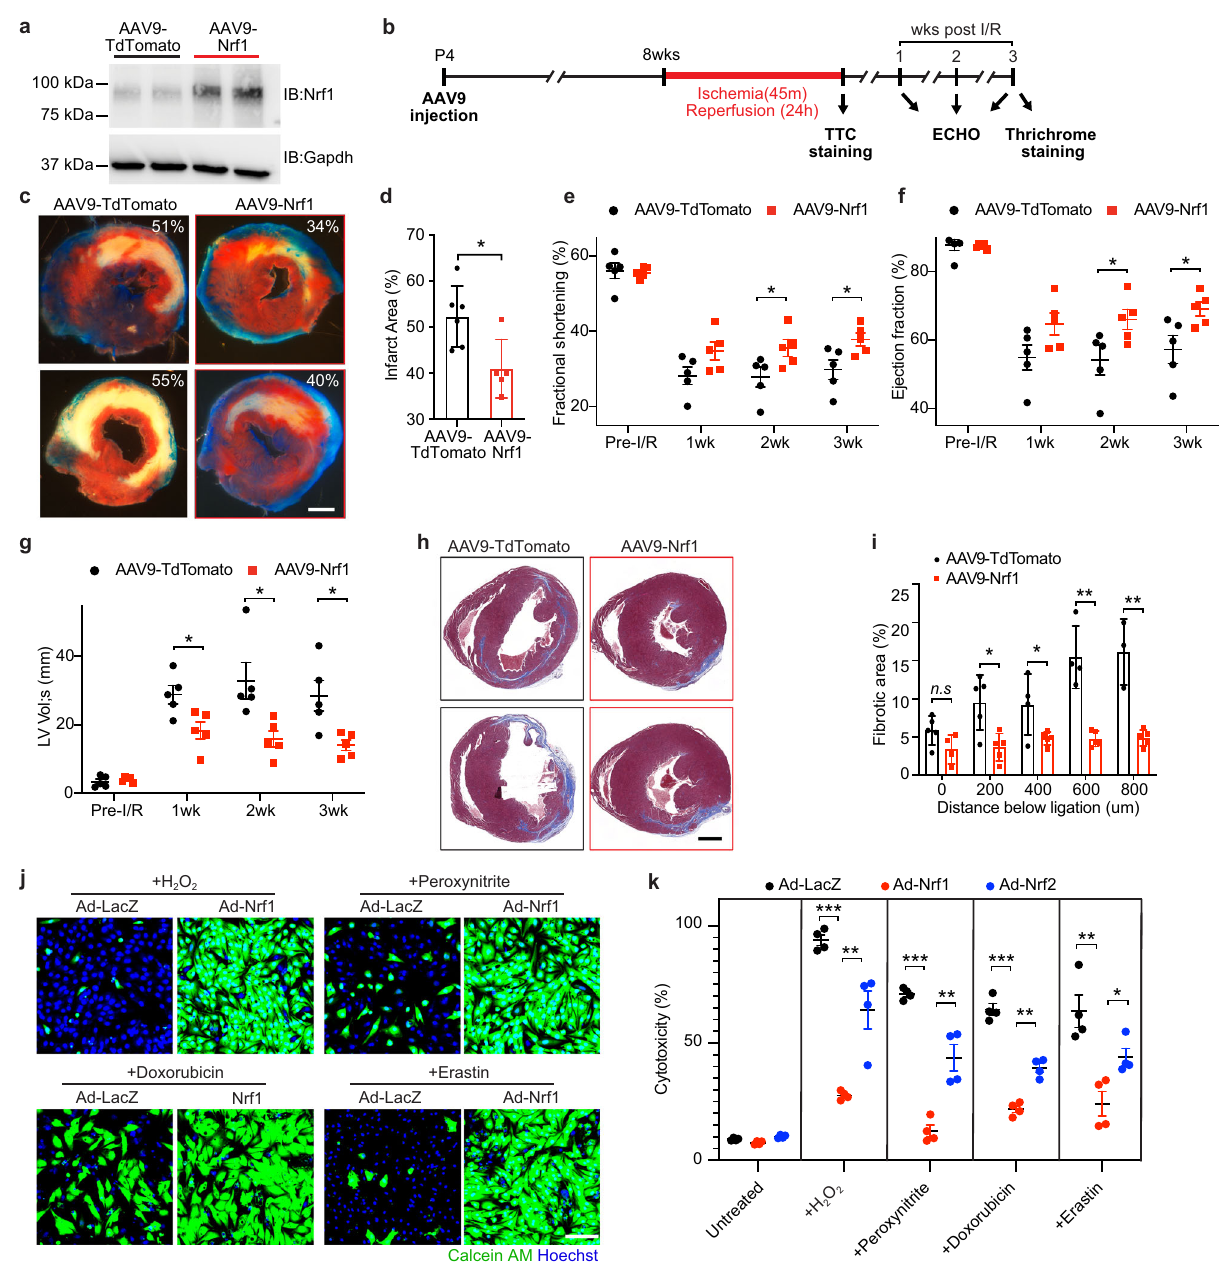
Fig. 3 Nrf1 overexpression protects cardiomyocytes against I/R and cardiotoxin injury. a Western blot analysis showing Nrf1 expression in hearts from mice at 4-week after AAV9-TdTomato and AAV9-Nrf1 injection at P4; experiments were repeated independently twice with similar results. b Illustration of a timeline showing the experimental design for AAV9 injection and time points of sample collections. c TTC staining showing infarct size on transverse heart sections collected at the end of reperfusion; Scale bar, 500 μ m. d Quanti fi cation of infarct area in sections from ( c ); AAV9-TdTomato, n = 6; AAV9- Nrf1, n = 5; * p = 0.0183, by Student ’ s t -test two-tailed. e – g Fractional shortening ( e ), ejection fraction ( f ), and systolic volume ( g ) of left ventricles from AAV9-TdTomato and AAV9-Nrf1 hearts at baseline (before I/R), and 1 – 3 weeks (wk) after I/R; n = 5 animals for each group. e 2wk, * p = 0.0388; 3wk, scarring on transverse sections of hearts collected at 600 μ m below the ligation suture; Scale bar, 500 μ m. i Quanti fi cation of fi brotic regions of heart sections collected at multiple planes below the ligation suture from AAV-TdTomato and AAV-Nrf1 mice; AAV9-TdTomato, n = 5; AAV9-Nrf1, n =